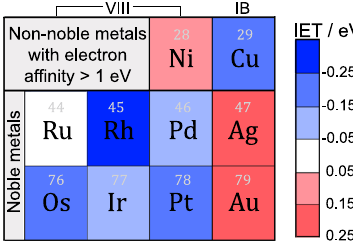
Fig. 1 Schematic of calculated IET energies in the presence of different metals on TiO 2 . Colors from red to blue indicate gradually enhancing IET energies (using M 8 /TiO 2 or M 7 /TiO 2 models) and the details are shown in Supplementary Table 1 and Supplementary Fig.